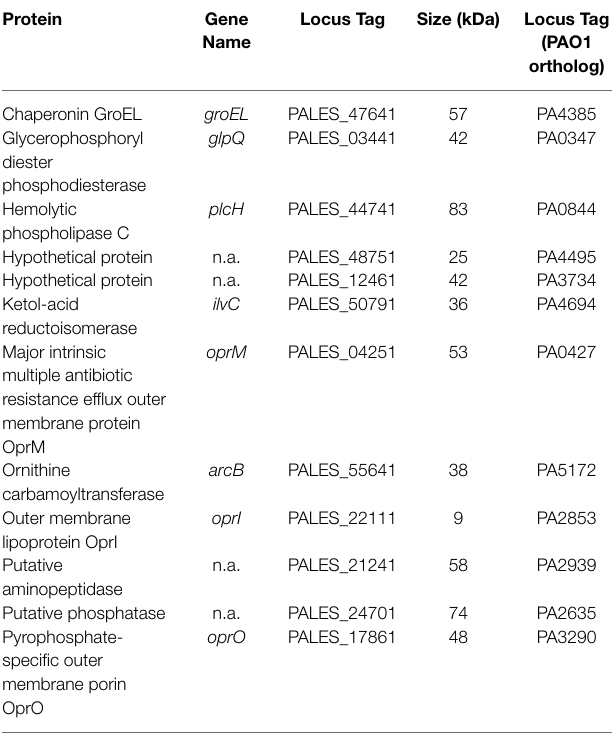
TABLE 1 | Complete list of Pseudomonas aeruginosa proteins found in the bacterial supernatant/liposome pellet.